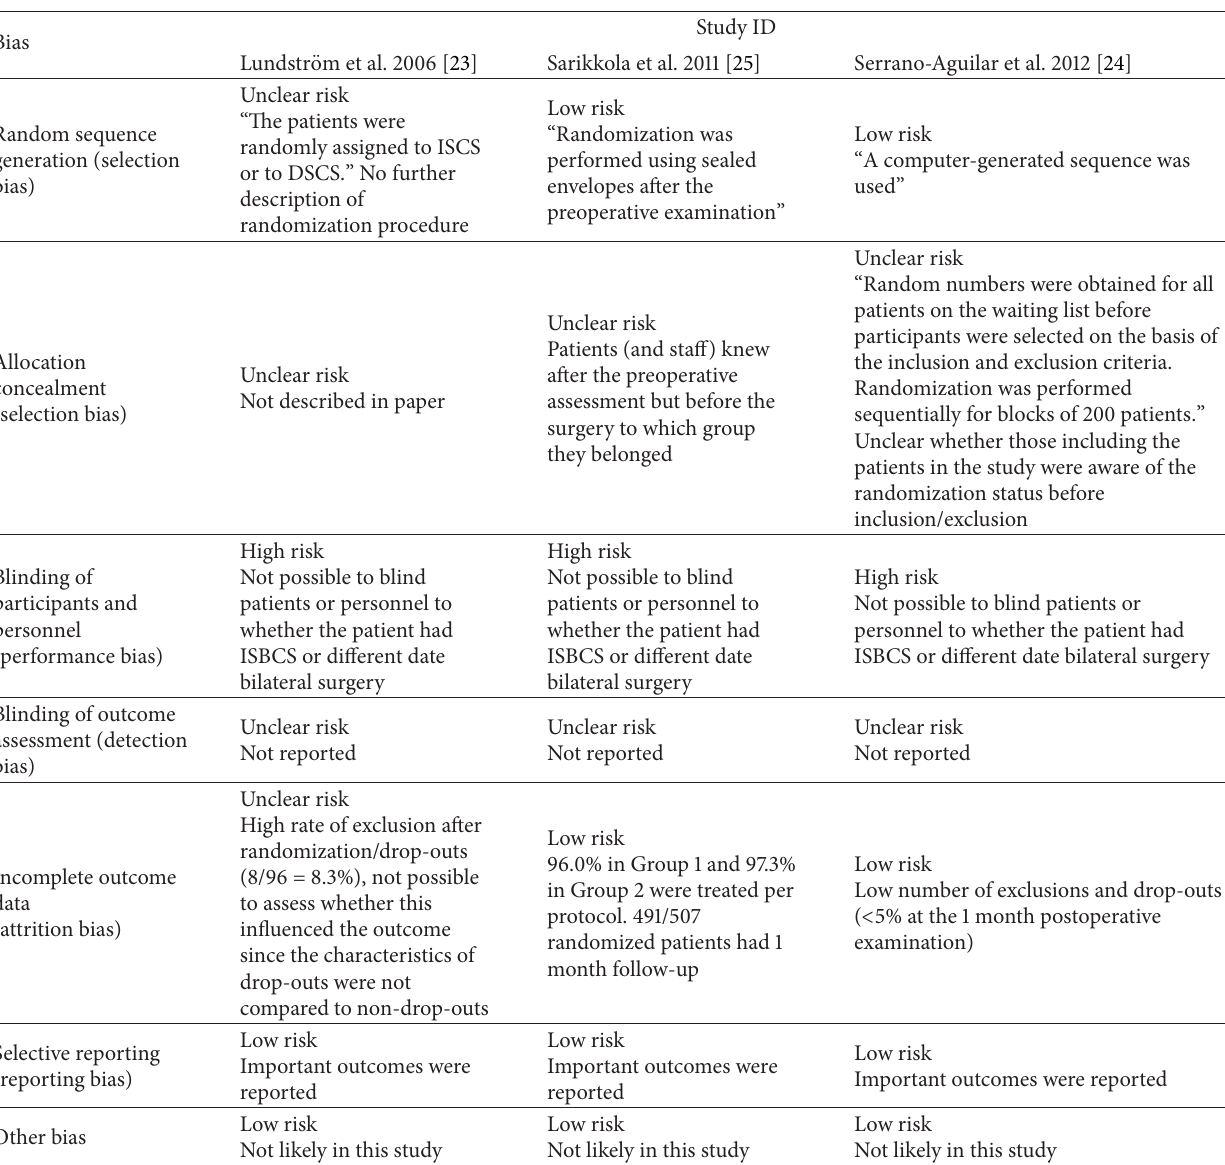
Table 2: Risk of bias in included